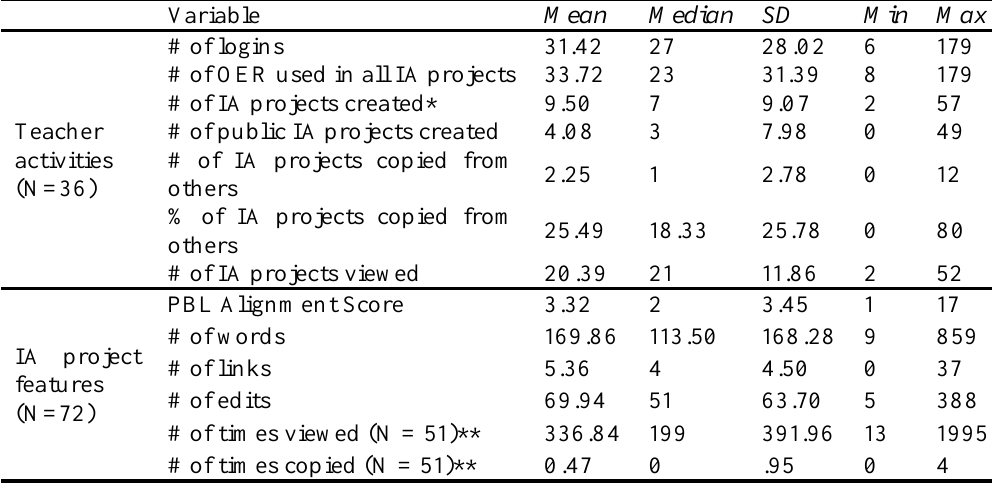
Descriptives of PD Participants’ (N = 36) Activity and IA Project Features (N = 72) (Data Collected over a 1-Year